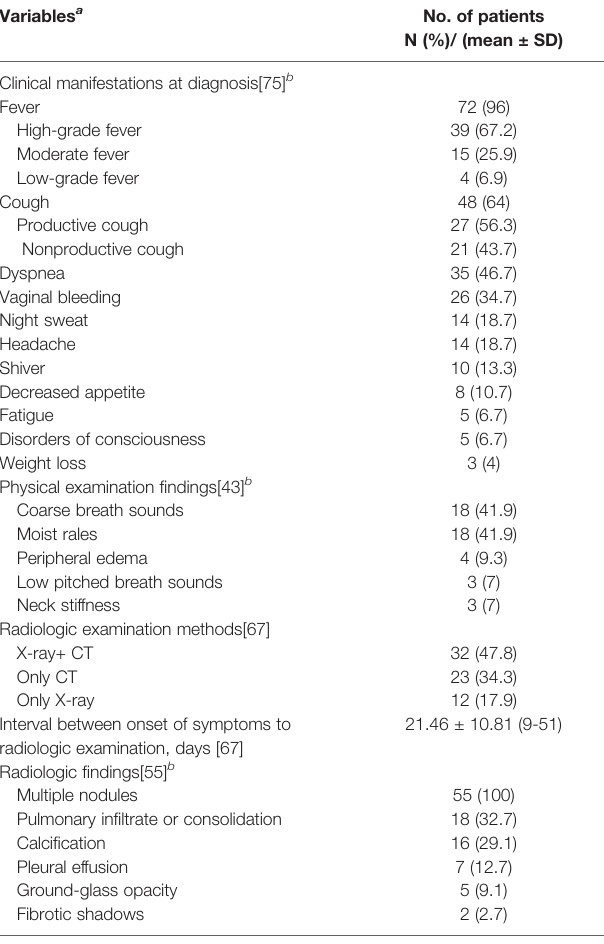
TABLE 3 | Clinical manifestations and radiologic fi ndings. Variables